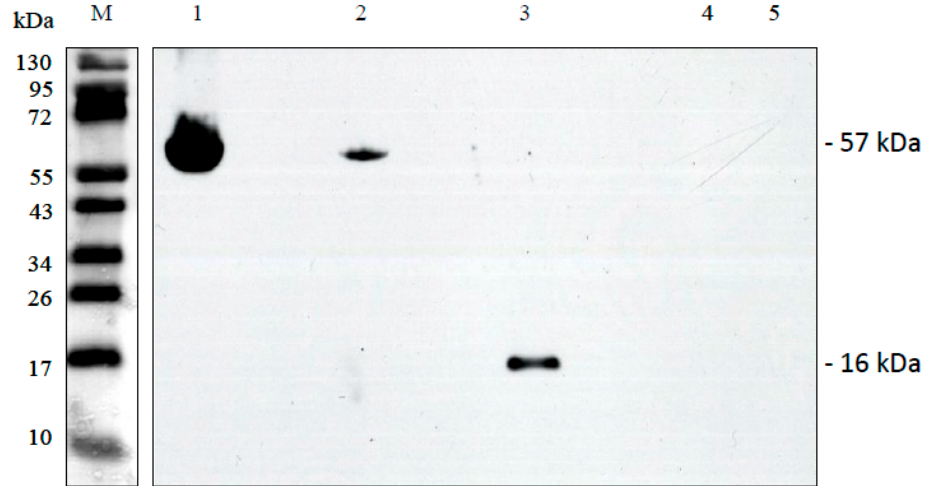
Figure 8. Immuno-blot using complete affinity-purified peptide Anti-ORF288 polyclonal antibody against 10 µg of isolated mitochondria from CMS PET2 and the fertile line HA89, ORF288 recombinant protein and protein plant extracts of CMS PET2 and HA89. Lanes: 1, CMS PET2 mitochondrial extracts; 2, HA89 mitochondrial extracts; 3, recombinant ORF288; 4, CMS PET2 whole plant protein extracts; 5, HA89 whole plant protein extracts; M, prestained protein ladder.